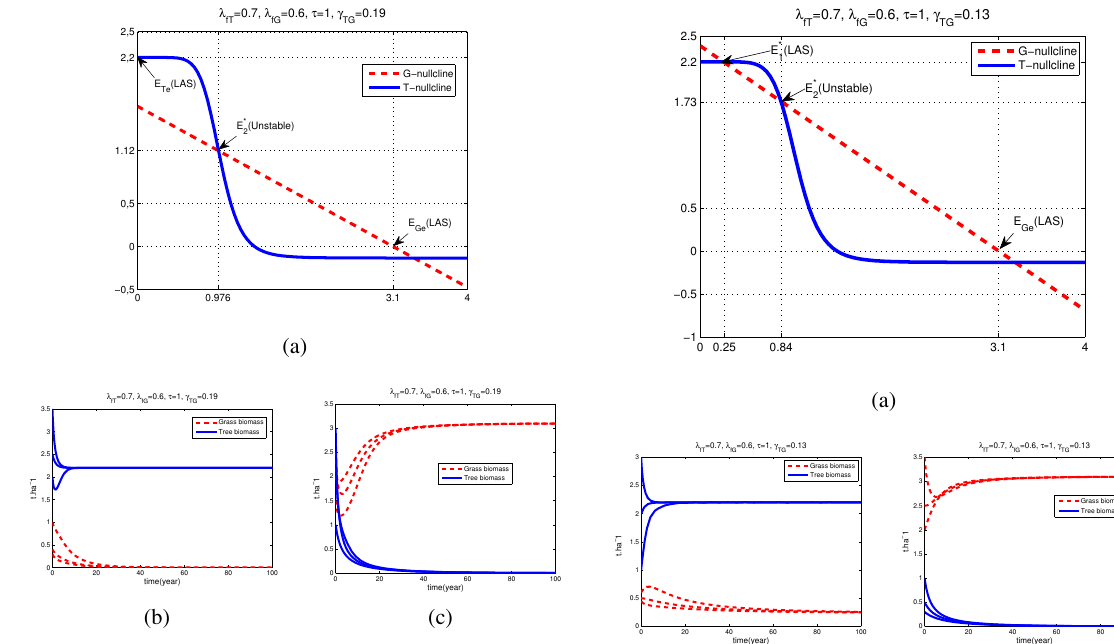
Fig. 12: (a) shows two basins of attraction: the separatrix which passes through the unstable internal equilibrium E ∗ 2 = (0 . 976;1 . 12) separates the two domains. Trajectories to the right of the separatrix = (3 . 1;0) and those to the left eventually eventually reach E G e = (0;2 . 2) . reach E T e (b) stable woody vegetation; (c) stable grassland.